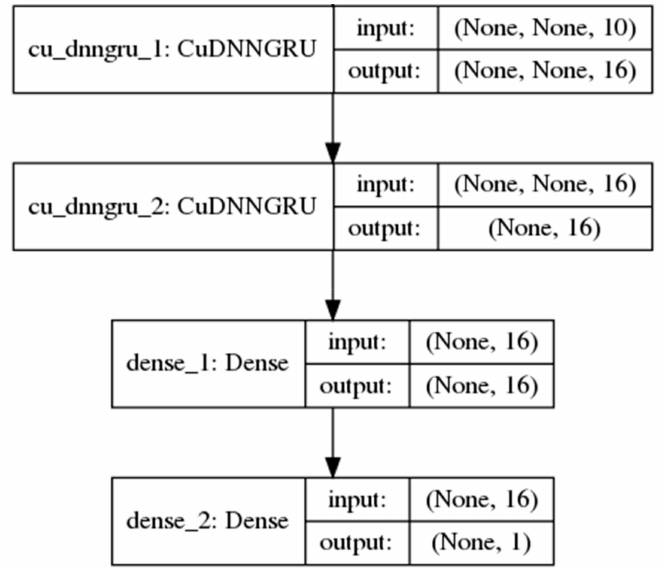
Figure 2. A neural network model with 2 single-direction gated recurrent unit (GRU) layers and 1 fully-connected